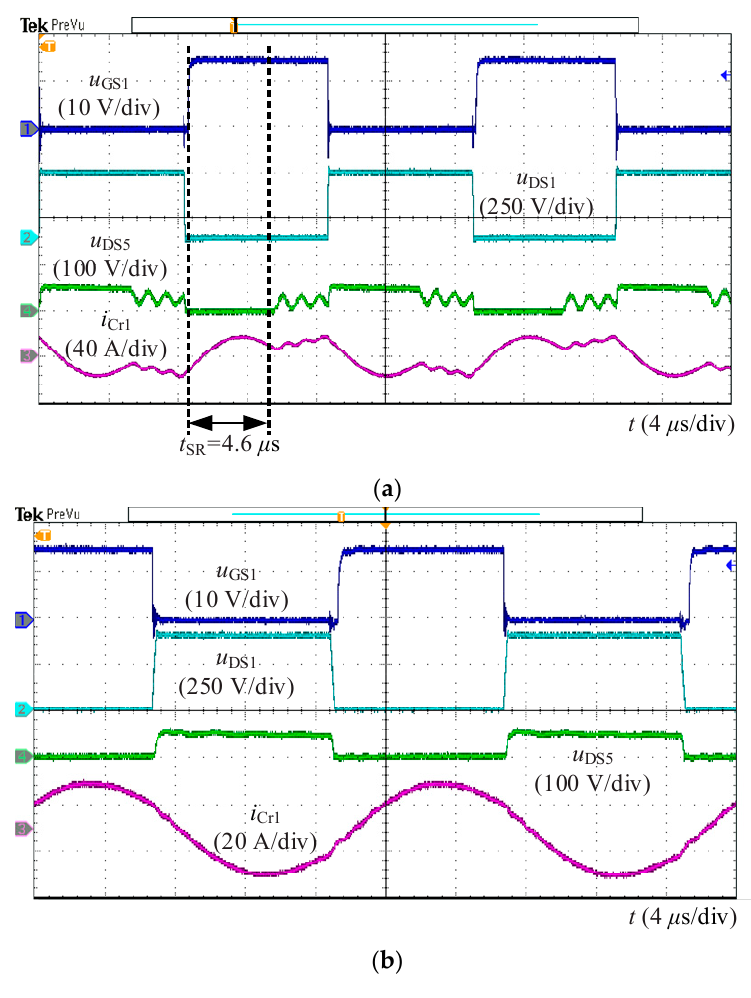
Figure 15. Experimental results in forward mode: ( a ) 60 kHz, 3.5 kW; ( b ) 100 kHz, 5 kW.